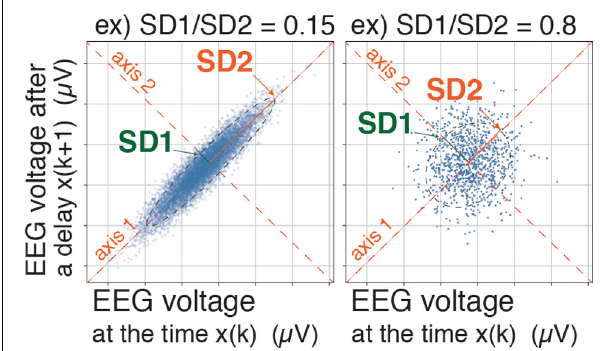
FIGURE 2 | Poincaré plot: SD1/SD2 and Poincaré plot area (SD1 × SD2 × π ). A pair of EEG voltages with 1/128-s time lag was plotted in the XY plane, first at a specific time (X: x ( k ) ) and then after a time delay (Y: x ( k + 1 ) ). SD1 represents the standard deviation of the Poincaré plot perpendicular to the line-of-identity, while SD2 represents the standard deviation of the Poincaré plot along the line-of-identity. EEG,